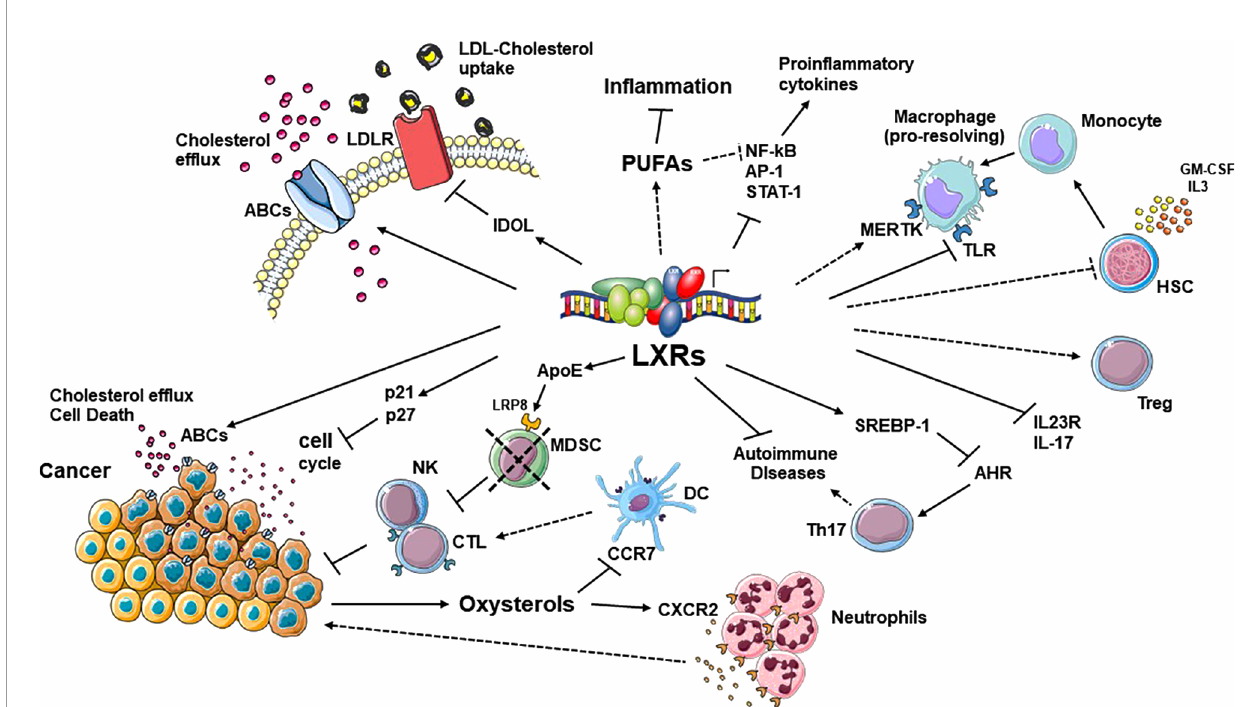
FIGURE 2 | Summary of the most relevant pathways regulated by LXRs in the context of cholesterol homeostasis, in fl ammation, autoimmunity and tumor progression. These NRs act in a cell-, tissue- and context-dependent manner. In addition, many LXR-dependent and -independent pleiotropic effects mediated by oxysterols, produced in in fl amed or tumoral microenvironments, add an additional level of complexity to these regulatory pathways. ABC, ATP binding cassette; AHR, aryl hydrocarbon receptor; APOE, apolipoprotein E; CTL, cytotoxic T lymphocyte; DC, dendritic Cell; DSS, IDOL, inducible degrader of the LDL-receptor; IRF3, interferon regulatory factor 3; LBD, ligand binding domain; PUFA, long-chain polyunsaturated fatty acid; LDLR, low-density lipoprotein receptor; LRP8, low-density lipoprotein receptor-related 8; MDSC, myeloid derived suppressor cells; MERTK, MER proto-oncogene tyrosine kinase; NK, natural killer; SREBP-1, sterol regulatory element-binding protein 1; TLR, Toll-like